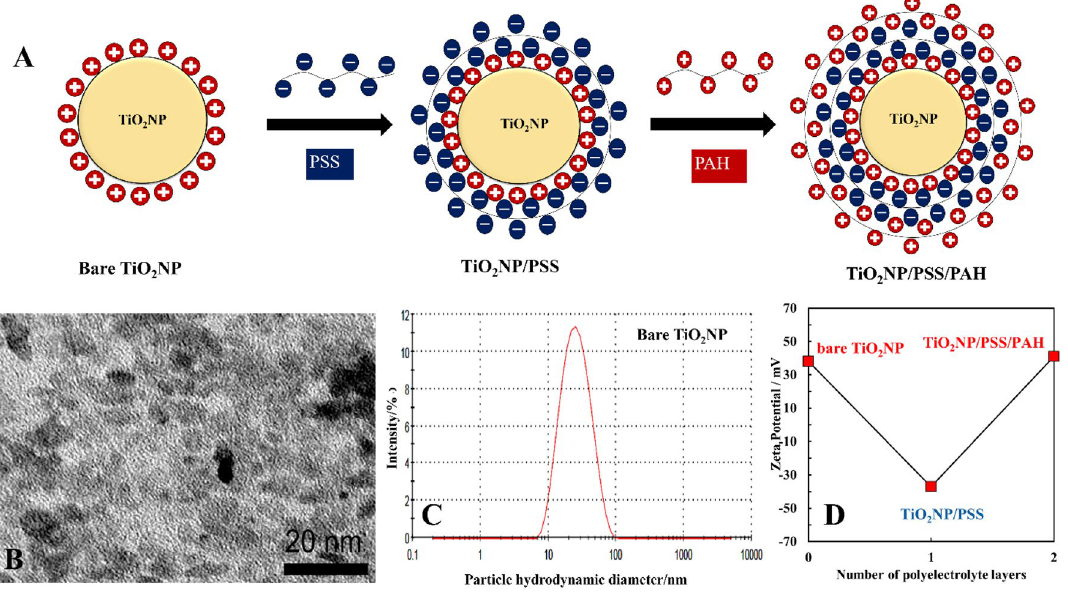
titanium isopropoxide at acidic medium for 20 h at 70 °C. d Zeta- NP with 2 potential of the bare TiO